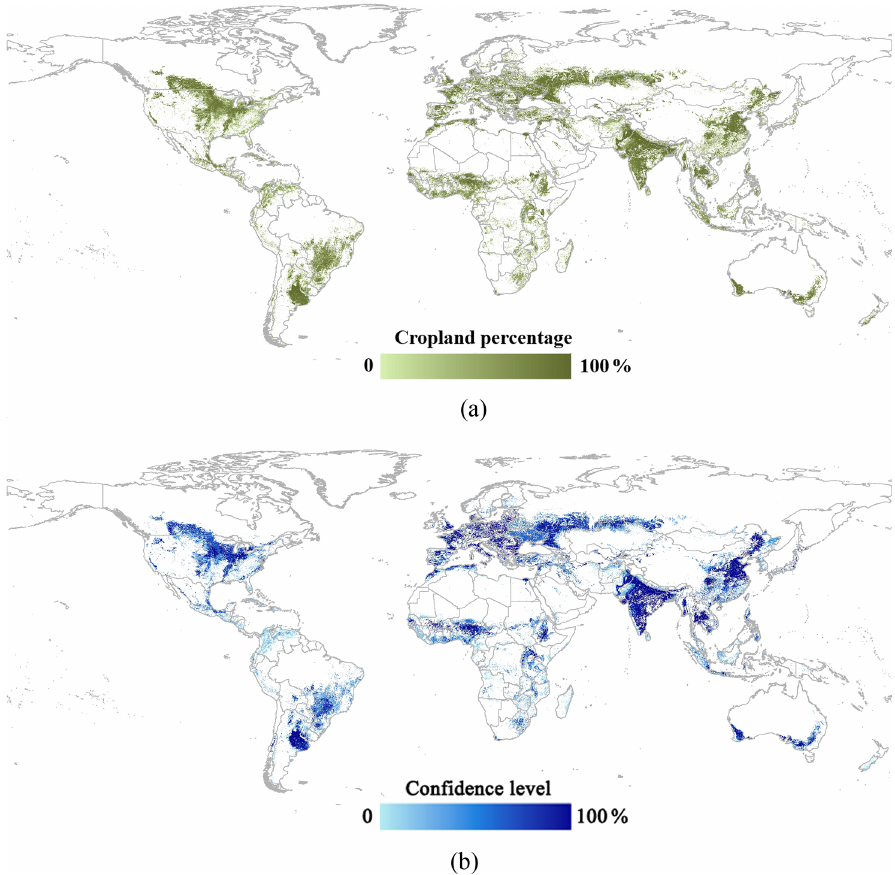
Figure 6. The results of global synergy cropland: (a) cropland percentage map, (b) confidence level of synergy cropland. Table 4. Overall accuracies of input datasets and synergy cropland at the continent and global scales. CCI-LC GlobCover GlobeLand30 MODIS C5 Unified Cropland Layer Synergy map